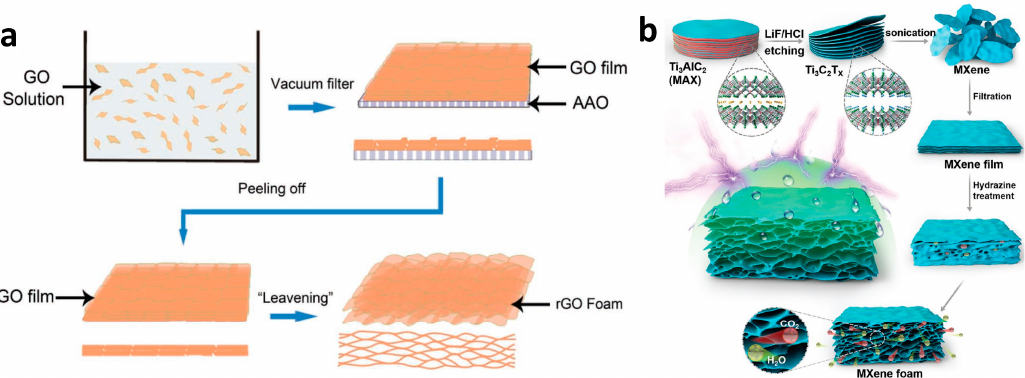
Figure 13. ( a ) Schematic illustration of the fabrication of the leavening process to prepare rGO foams; reproduced from [54], with the permission of Wiley-VCH. ( b ) Schematic diagram of the synthesis of the hydrophobic and flexible MXene foam; reproduced from [56], with the permission of Wiley-VCH.